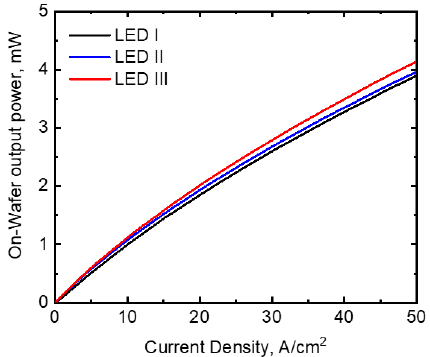
Figure 4. On-wafer L - I of experimental LEDs.